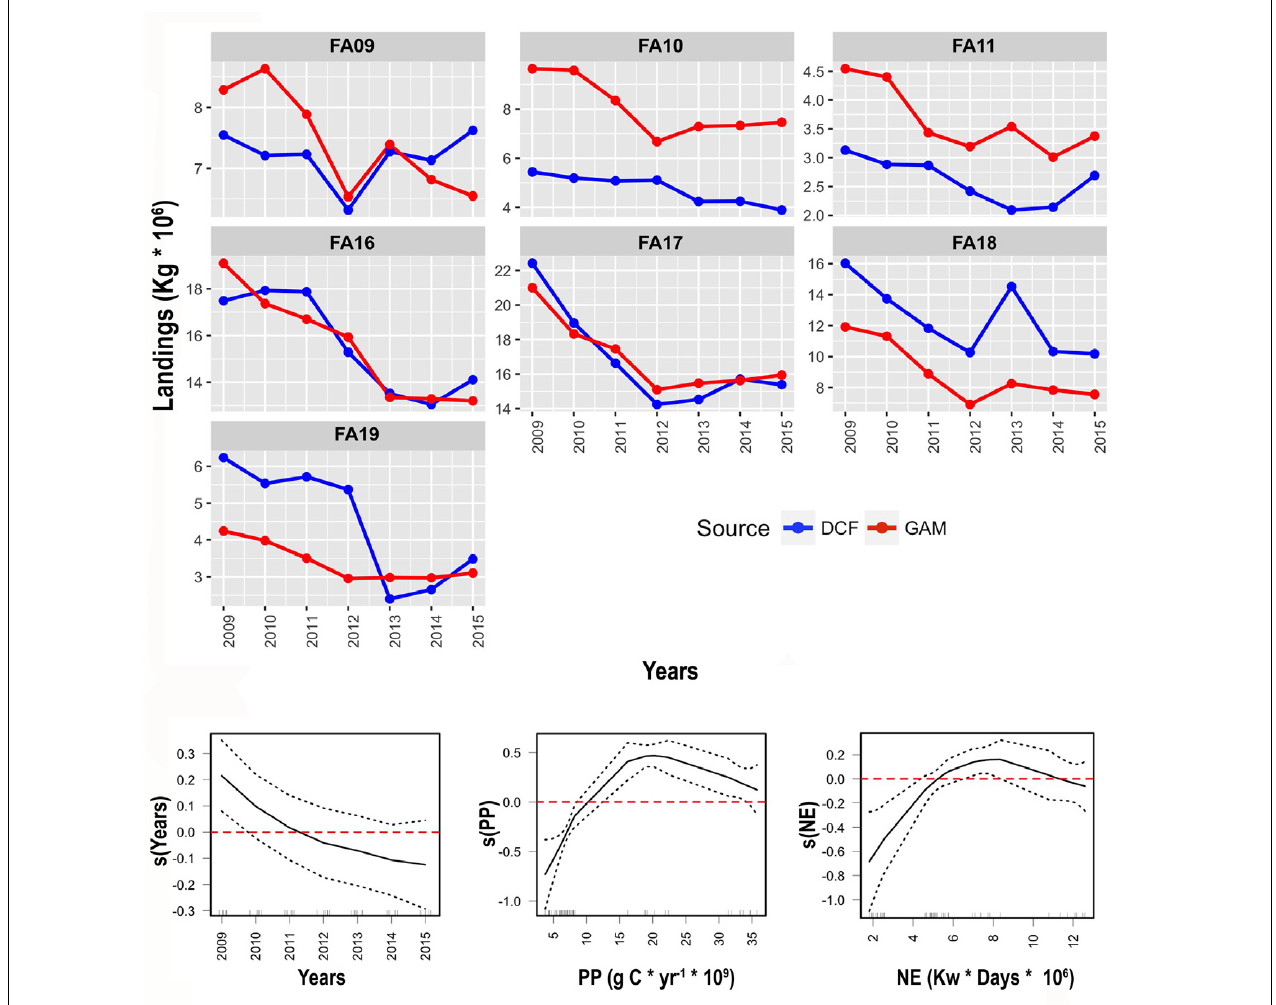
FIGURE 8 | (A) Comparisons between actual trends (source: DCF, blue lines and dots) and GAM-based models of Fisheries Yield, during the period 2009–2015. The effects of the different predictors (if significant), independent of the other predictors, are represented as response variable shape. The degree of smoothing is indicated in the y -axis label. (B) Confidence intervals (95%) around the response curve are represented by dashed lines.